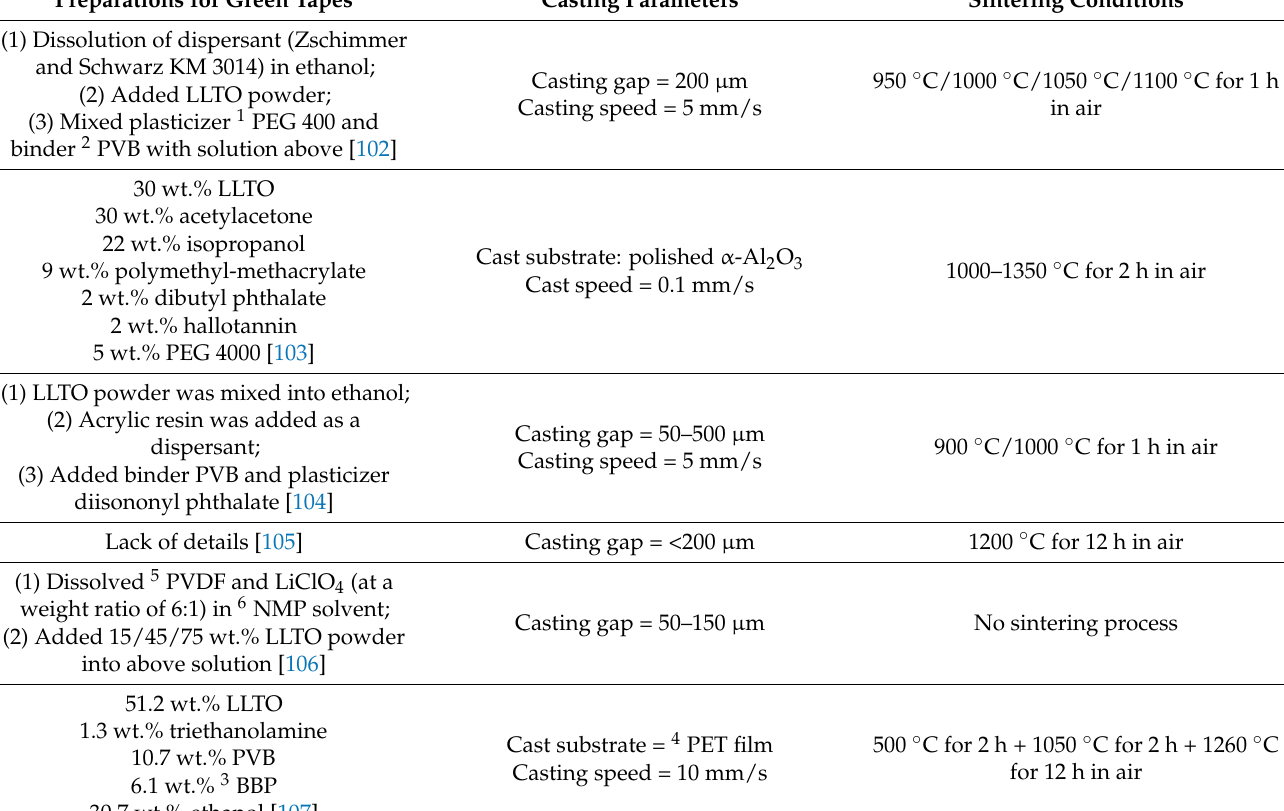
Table 3. Summary of preparations for green tapes and casting/sintering parameters. Preparations for Green